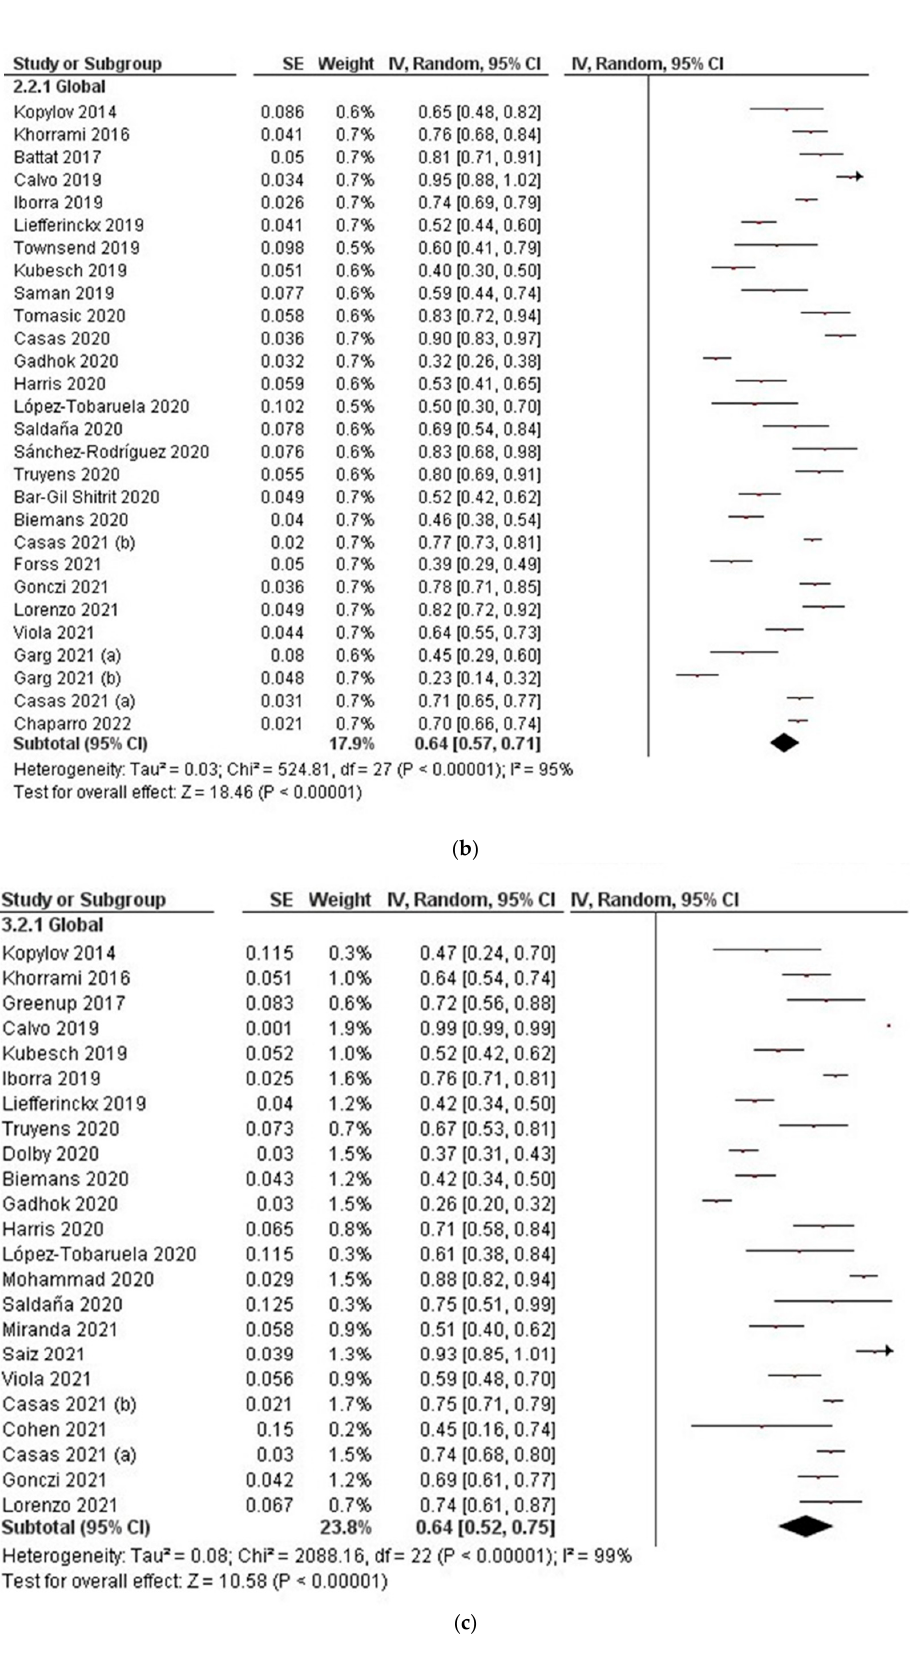
Figure 2. Clinical response to ustekinumab in Crohn’s disease: ( a ) clinical response in the short term (8 w–14 w); ( b ) clinical response in the medium term (16 w–24 w); ( c ) clinical response in long term (48 w–52